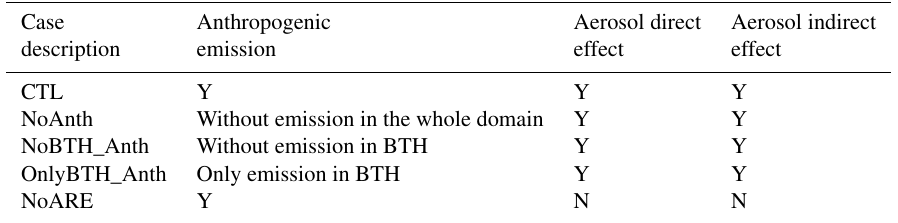
Table 2. Experimental design. “Y” represents yes, and “N” represents no. Case Anthropogenic Aerosol direct Aerosol indirect description emission effect effect CTL Y Y Y NoAnth Without emission in the whole domain Y Y NoBTH_Anth Without emission in BTH Y Y OnlyBTH_Anth Only emission in